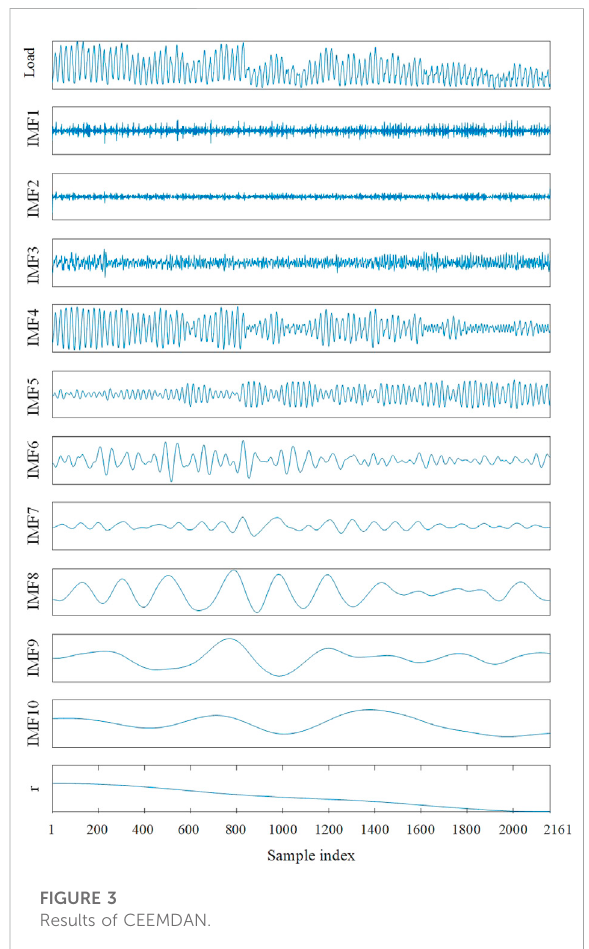
FIGURE 3 Results of